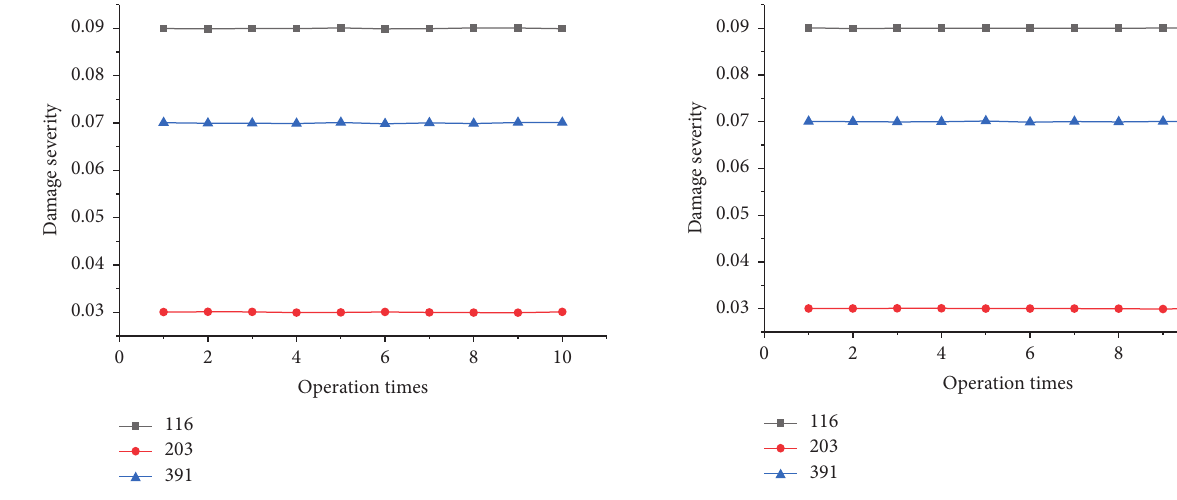
Figure 22: Damage severity identification of IPSO.